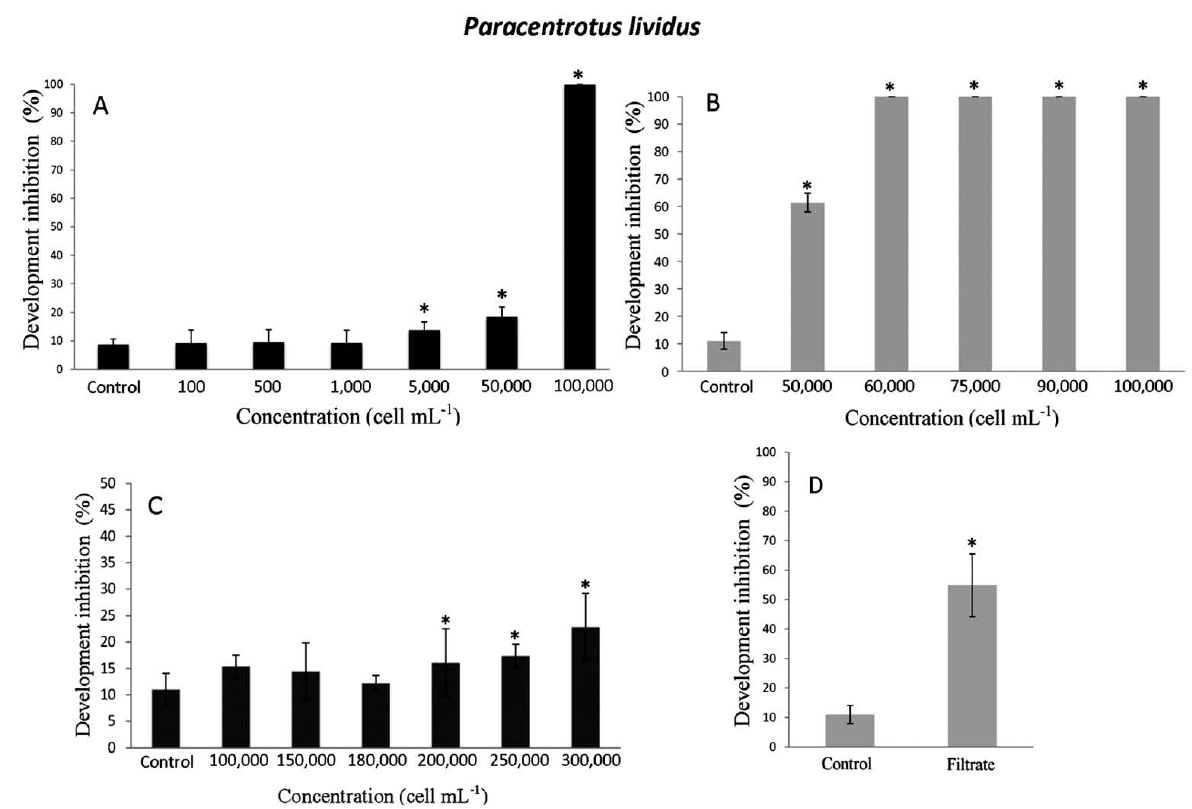
Fig. 3. – Percentage of Paracentrotus lividus embryonic development inhibition as a function of algal cell concentration with standard error of the mean for Alexandrium minutum culture of the initial (A) and definitive (B) tests and for Prymensium parvum culture (C) and filtrate (D). *: Significant differences